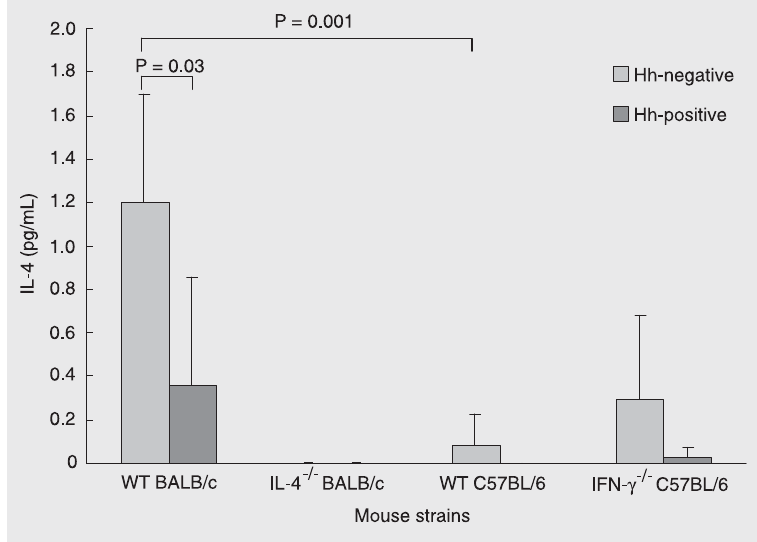
Figure 1. Serum IL-4 levels in Helicobacter heilmannii -negative and -positive wild-type and knockout BALB/c and C57BL/6 mice. Hh = H. heilmannii ; WT = wild type; -/- = knockout; IFN = interferon; IL-4 = interleukin-4. P values are shown only when the differences were significant (Student t